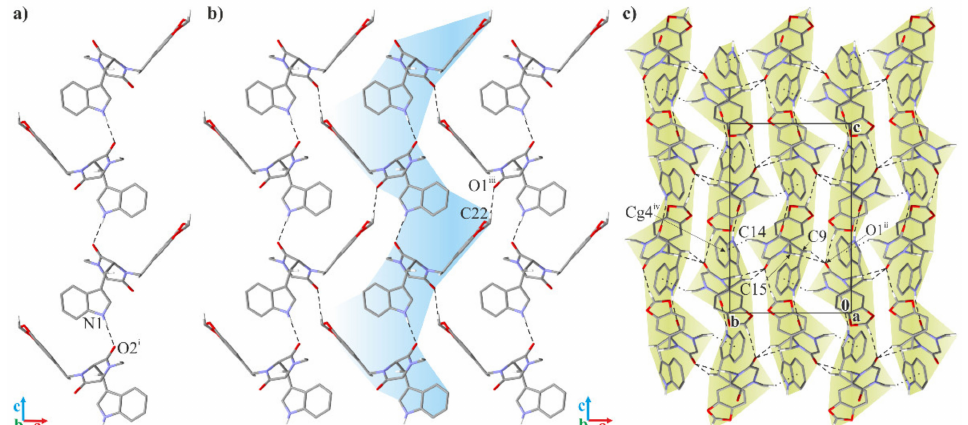
Figure 7. Arrangement of molecules of 6a in the crystal, where: ( a ) chain of molecules running along [001] direction; ( b ) single layer of molecules spreading along (100) plane (single chain of molecules is highlighted in blue); ( c ) general view on layered supramolecular architecture of compound viewed along a -direction (single layers are highlighted in light green). The H-atoms not involved in intermolecular interactions have been omitted for clarity. The N–H · · · O and C–H · · · O hydrogen bonds are represented by dashed lines, while the C–H · · · π contacts by dotted lines. Symmetry codes: